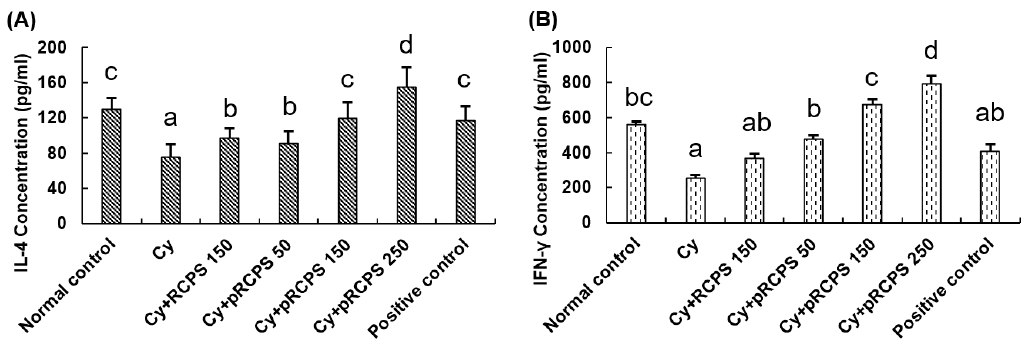
Figure 7. The e ff ects of pRCPS on IL-4 ( A ) and IFN- γ ( B ) level in the supernatants of splenocytes in Cy-immunosuppressed mice. Cy-immunosuppressed mice were orally treated with pRCPS solution (equivalent to 50, 150, and 250 mg of pRCPS / mouse / day) for 18 days. 24 h after the last dose, splenocytes were isolated and cultured with ConA (5 µ g / mL) or RPMI-1640 (control) for 48 h. The cytokine (IL-4 and IFN- γ ) concentration of supernatants of splenocyte was measured by ELISA. Data represent the mean ± SD ( n = 7). Bars marked with di ff erent letters indicate di ff erences that are statistically significant ( p <